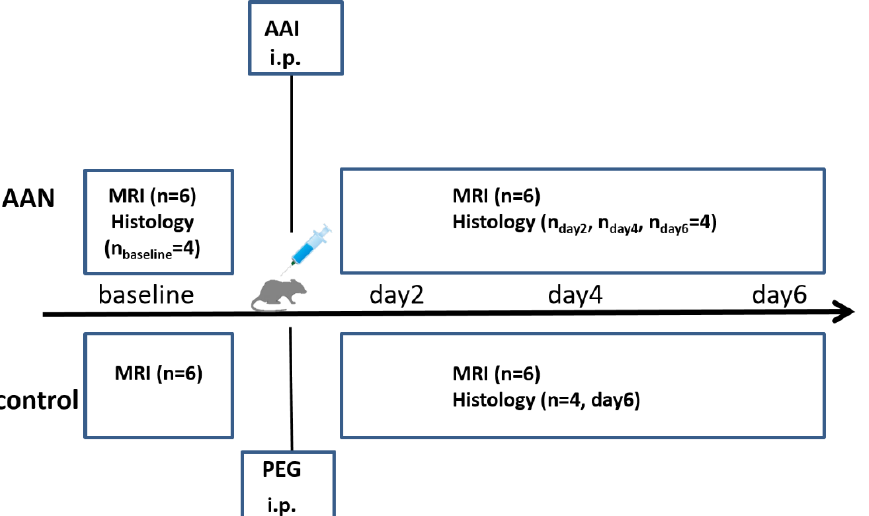
Figure 1. Schematic representation of the experimental protocol performed in rats involving an AAN group and a control group. Kidneys and blood samples were collected after each MRI exami- nation of the AAN group, and after the last MRI examination in the control group. AAN: aristolochic acid nephropathy; AAI: aristolochic acid I; i.p.: intraperitoneal injection; PEG: polyethylene